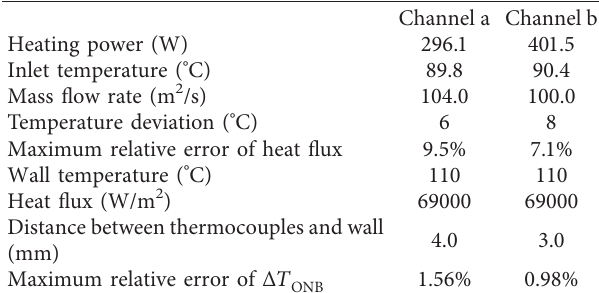
Figure 16: Comparison of average equivalent radius between two Table 5: Relative